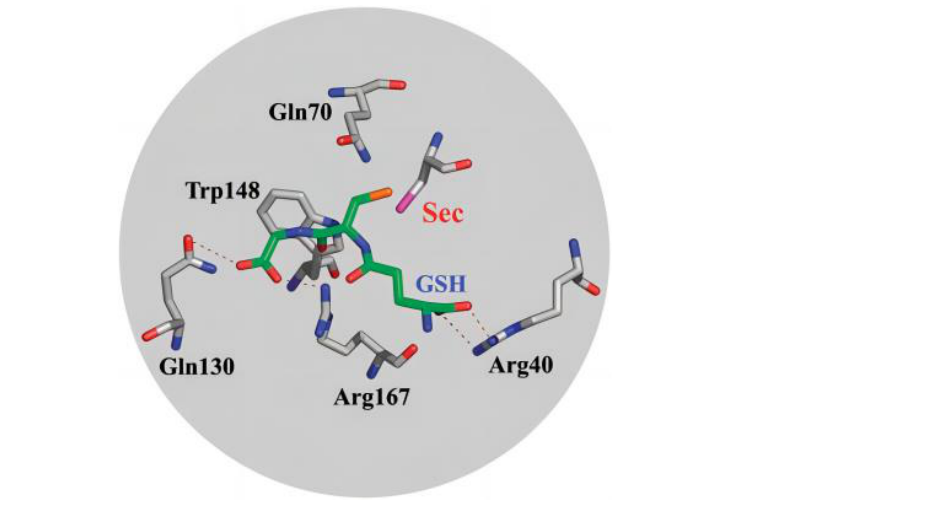
Figure 1. cGPx activity site map: structure for GSH and Arg40, Arg167, and Gln130. Reproduced with permission from X. Huang, et al. [10].